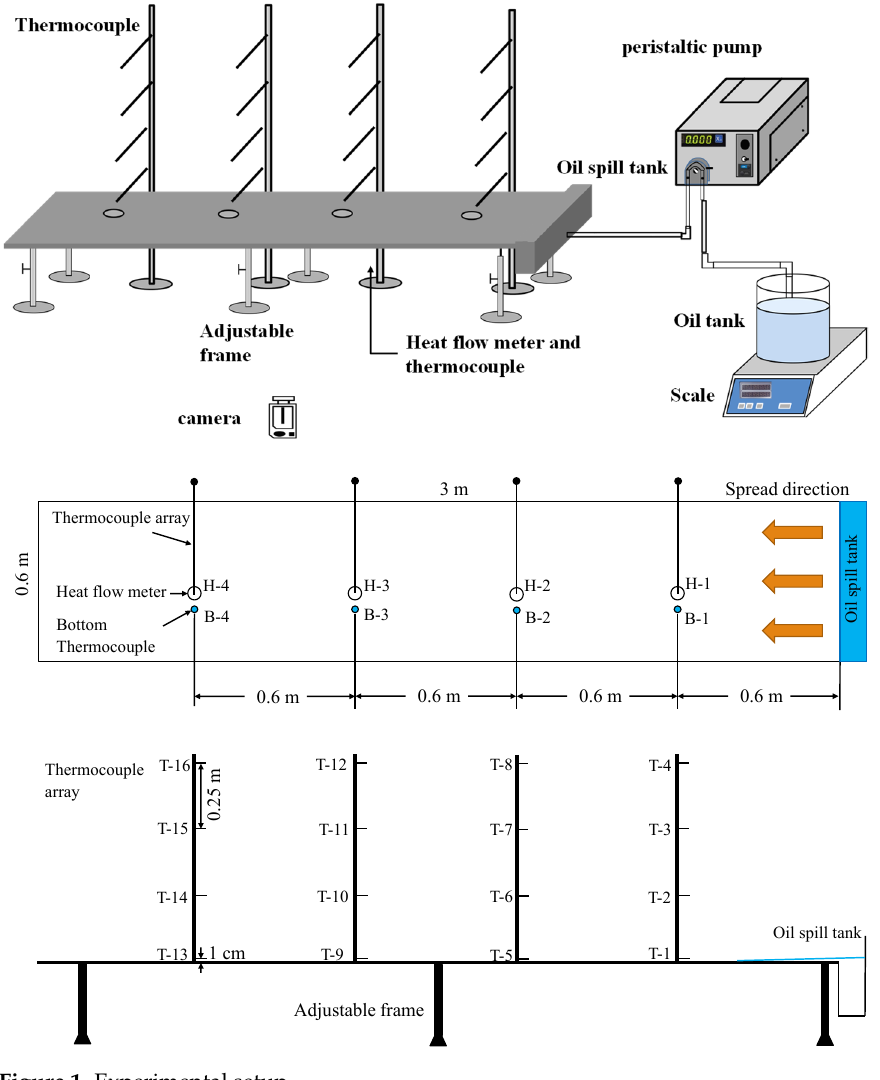
Figure 1. Experimental setup.